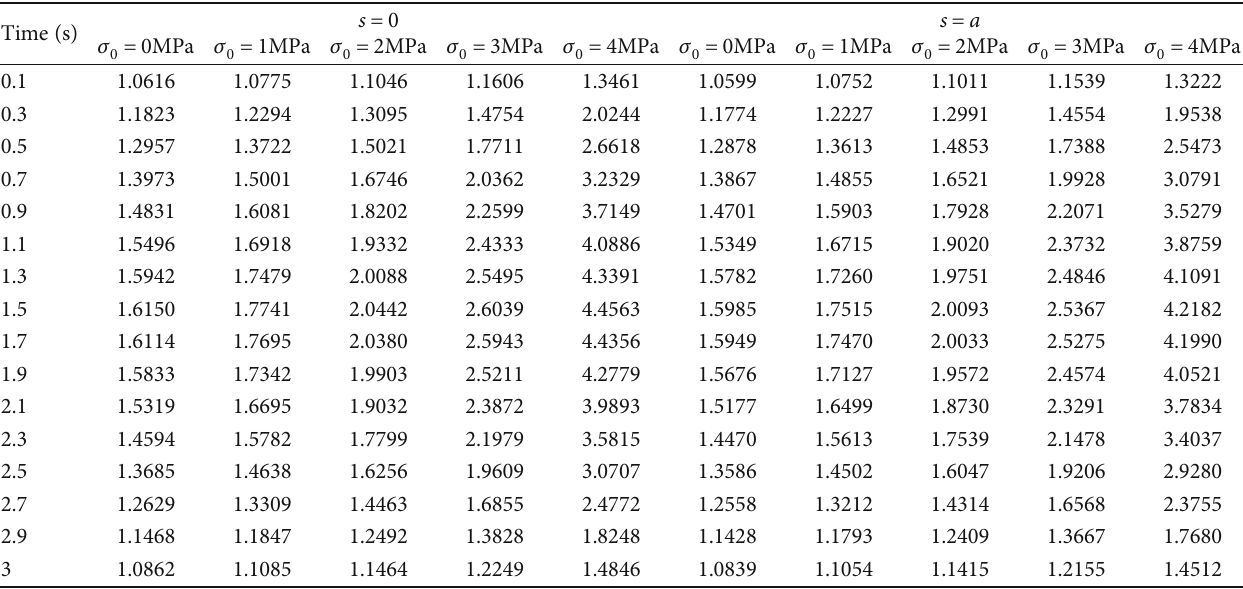
ΙΙ under di ff erent con fi ning pressure ( σ d